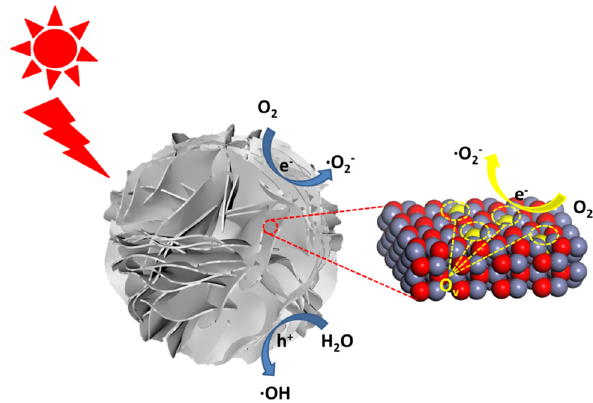
Figure 12: The photocatalytic mechanism of fl ower - like ZnO with exposed 21¯1¯0 { }